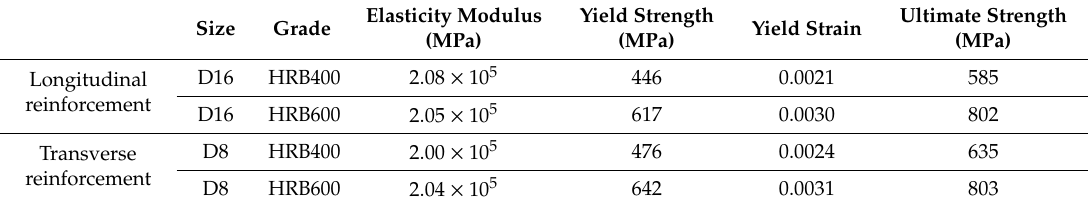
Table 2. Properties of the reinforcing